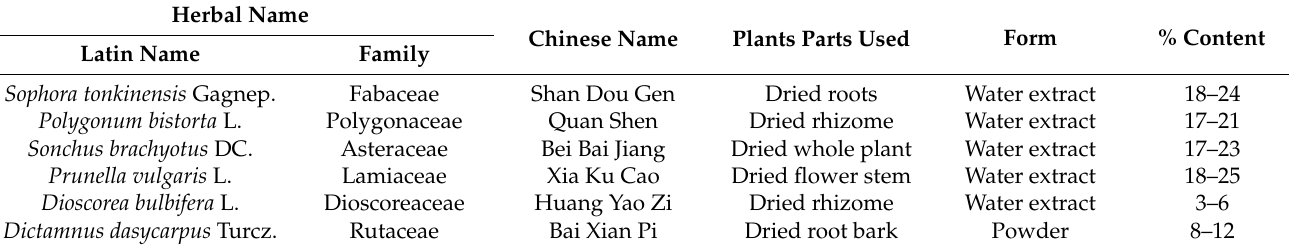
Table 1. Botanical raw materials of ATB extract (percent